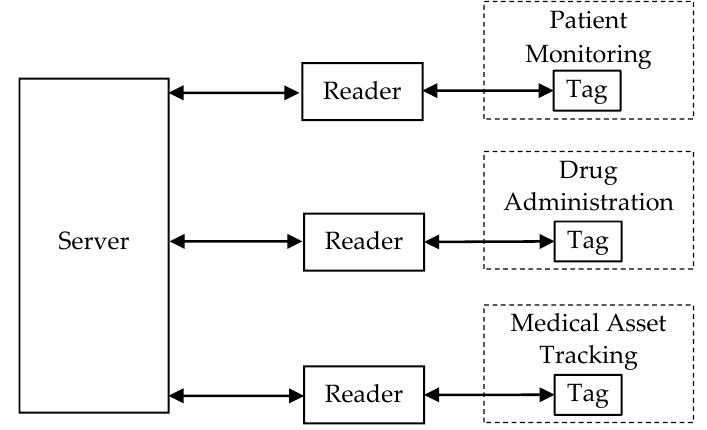
Figure 1. A typical radio frequency identification (RFID)-based healthcare system.